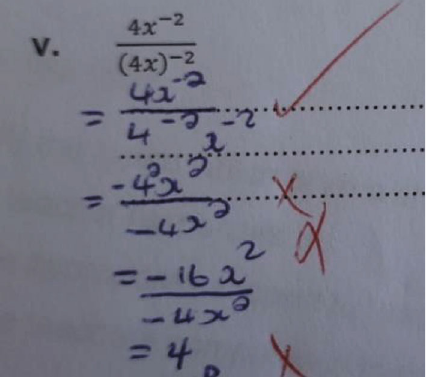
Figure 7: Learner K, School